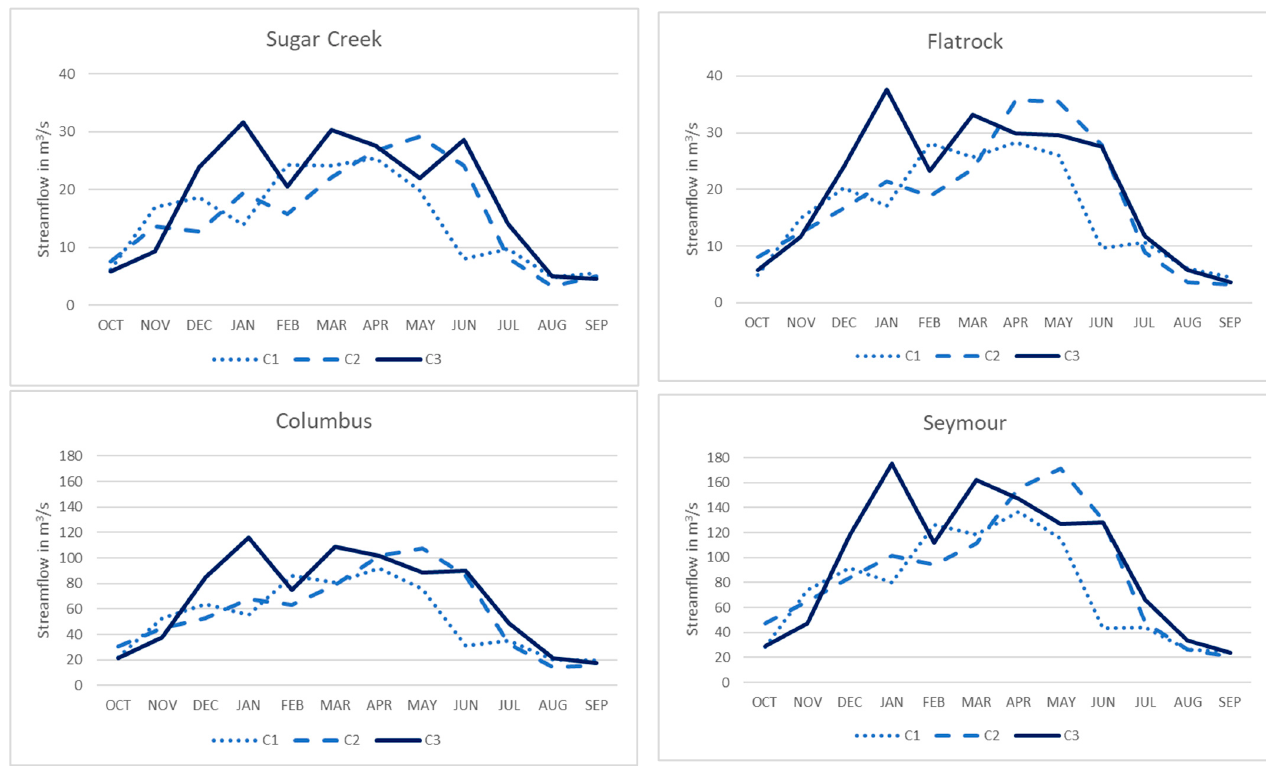
Figure 3. Monthly average streamflow (in m 3 /s) in water years for the gauging stations distributed in the configuration periods.